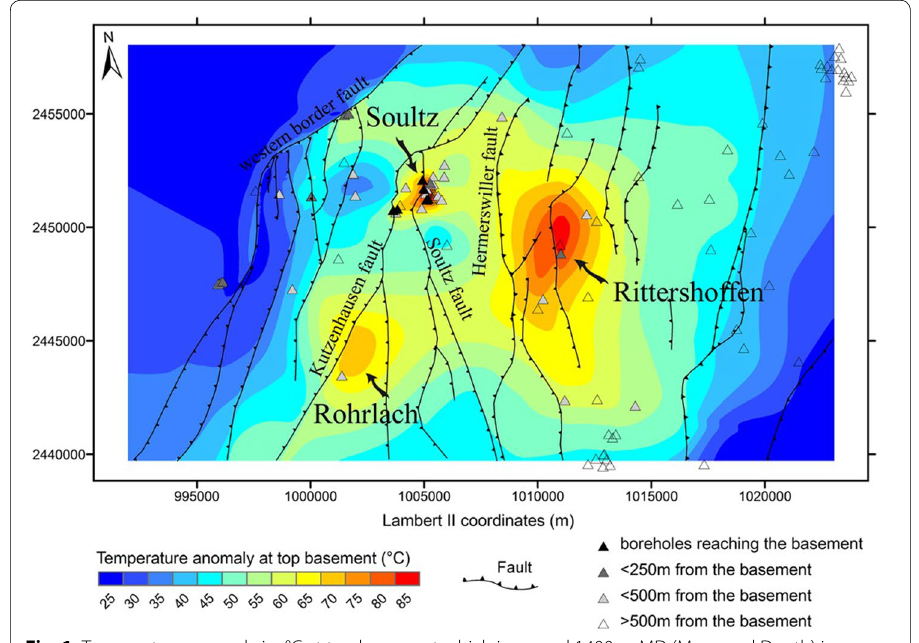
Fig. 1 Temperature anomaly in °C at top basement which is around 1400 m MD (Measured Depth) in Soultz‑sous‑Forêts and around 2200 m MD in Rittershoffen (Aichholzer et al. 2015). Fault traces with their dip directions and boreholes represented by triangles are also shown (From Baillieux et al.